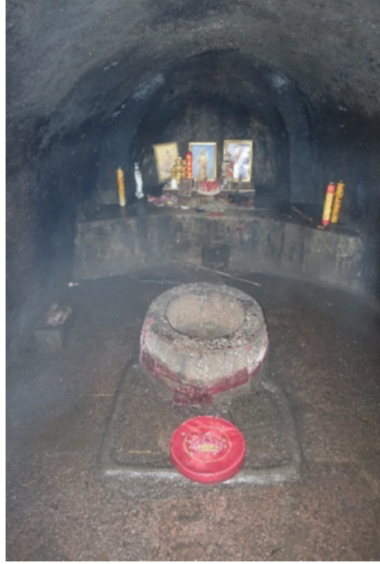
Figure 3. Well of the Immortal.